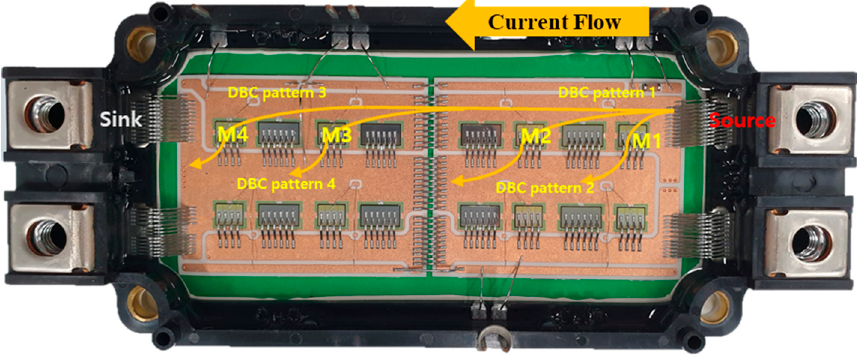
Figure 4. Current flow in power module for ANSYS Q3D simulation: current flow.